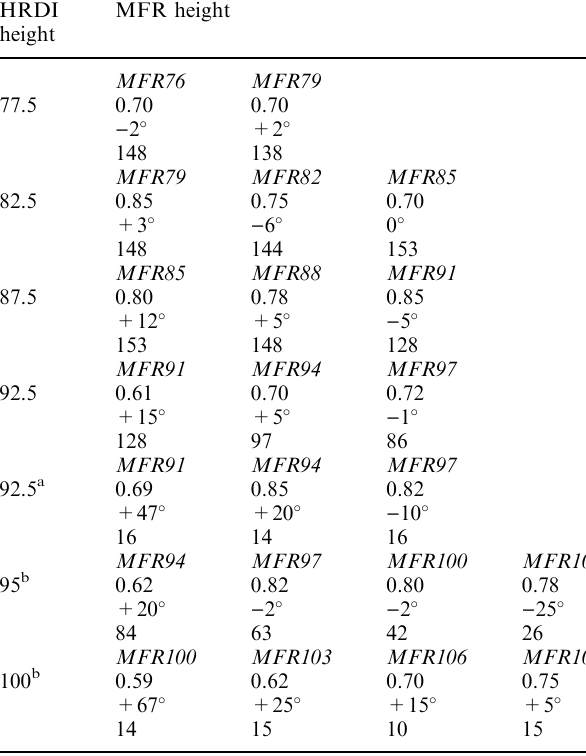
Table 1. Median speed-ratio (MFR/HRDI), direction di(cid:128)erence, and number of values for single height comparisons: MFR heights across, HRDI heights down HRDI height